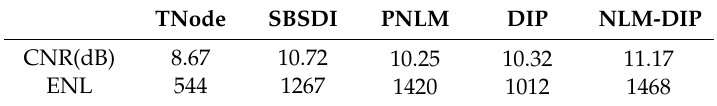
Table 1. Metrics comparison of different despeckling algorithms on the synthetic dataset.